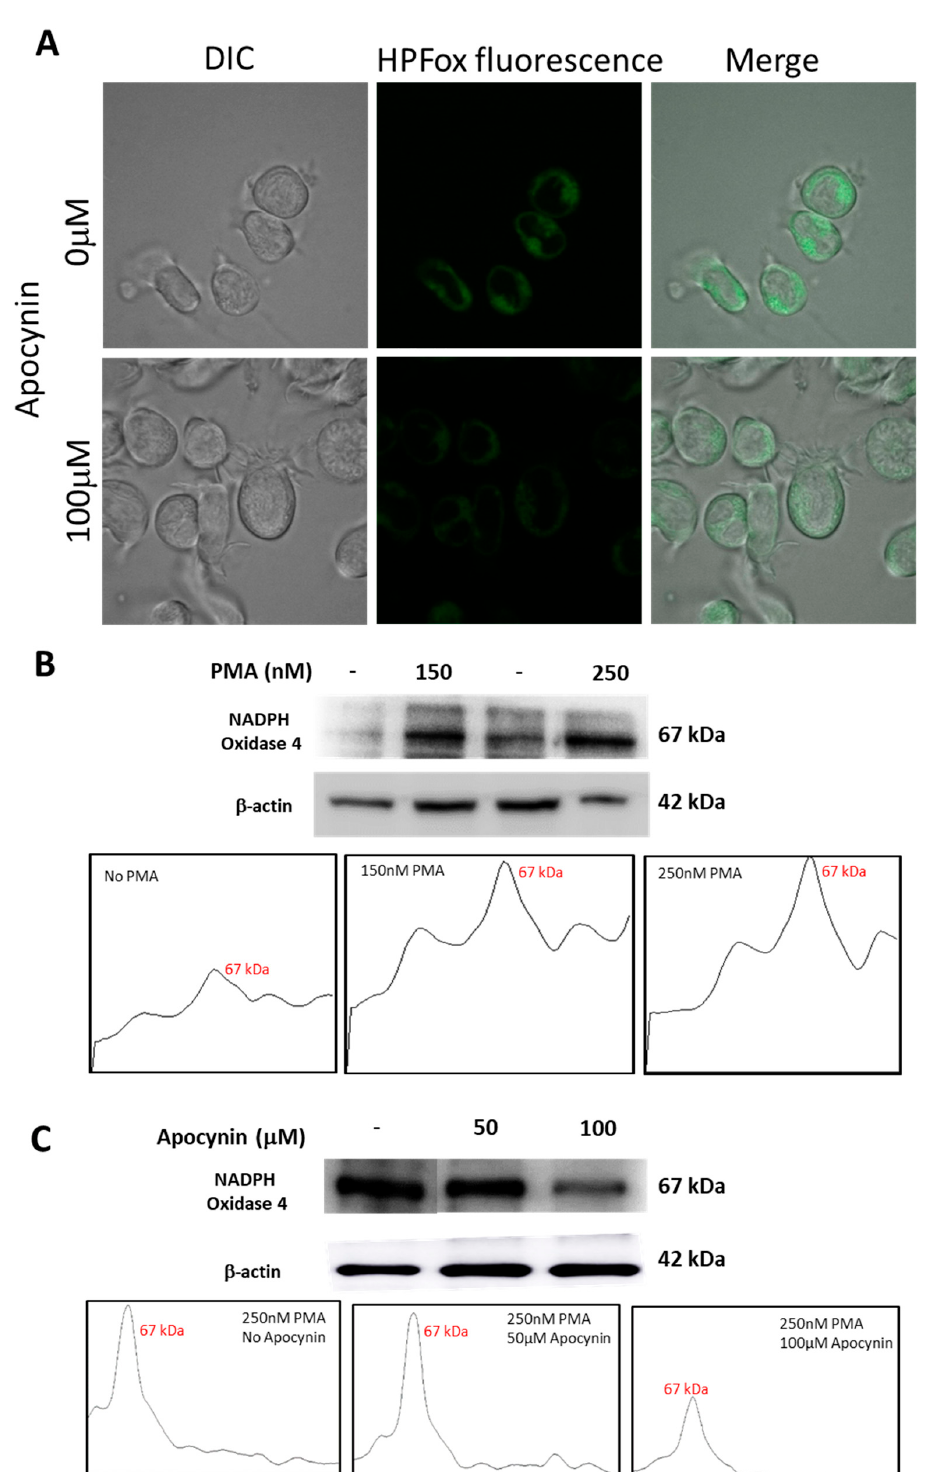
Figure 9. ( A ) Hydroxyl radical imaging using CLSM. U-937 cells were incubated with 1 µM HPF and 250 nM PMA in the absence (upper panel) and presence (lower panel) of 100 µM apocynin. Images from DIC channel and HPF-ox fluorescence (green signal) are presented. ( B ) Western blot analysis of NADPH oxidase 4 expression in whole-cell homogenate samples treated with 150 nM and 250 nM of PMA for 72 h and their corresponding densitograms. ( C ) Western blot analysis of NADPH oxidase 4 expression in 250 nM PMA differentiated whole cell homogenates pre-treated with 50 µM and 100 µM apocynin and their corresponding densitograms.